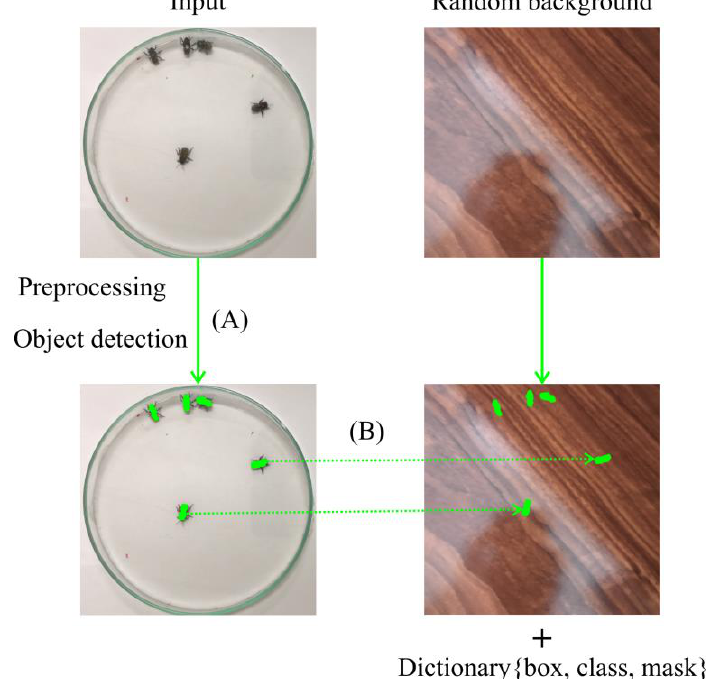
Figure 5. Schematic representation of the heuristic used to generate labeled images for the IS model automatically. The segmented objects (indicated by green masks) on a homogeneous background ( A ) are glued to random backgrounds ( B ).